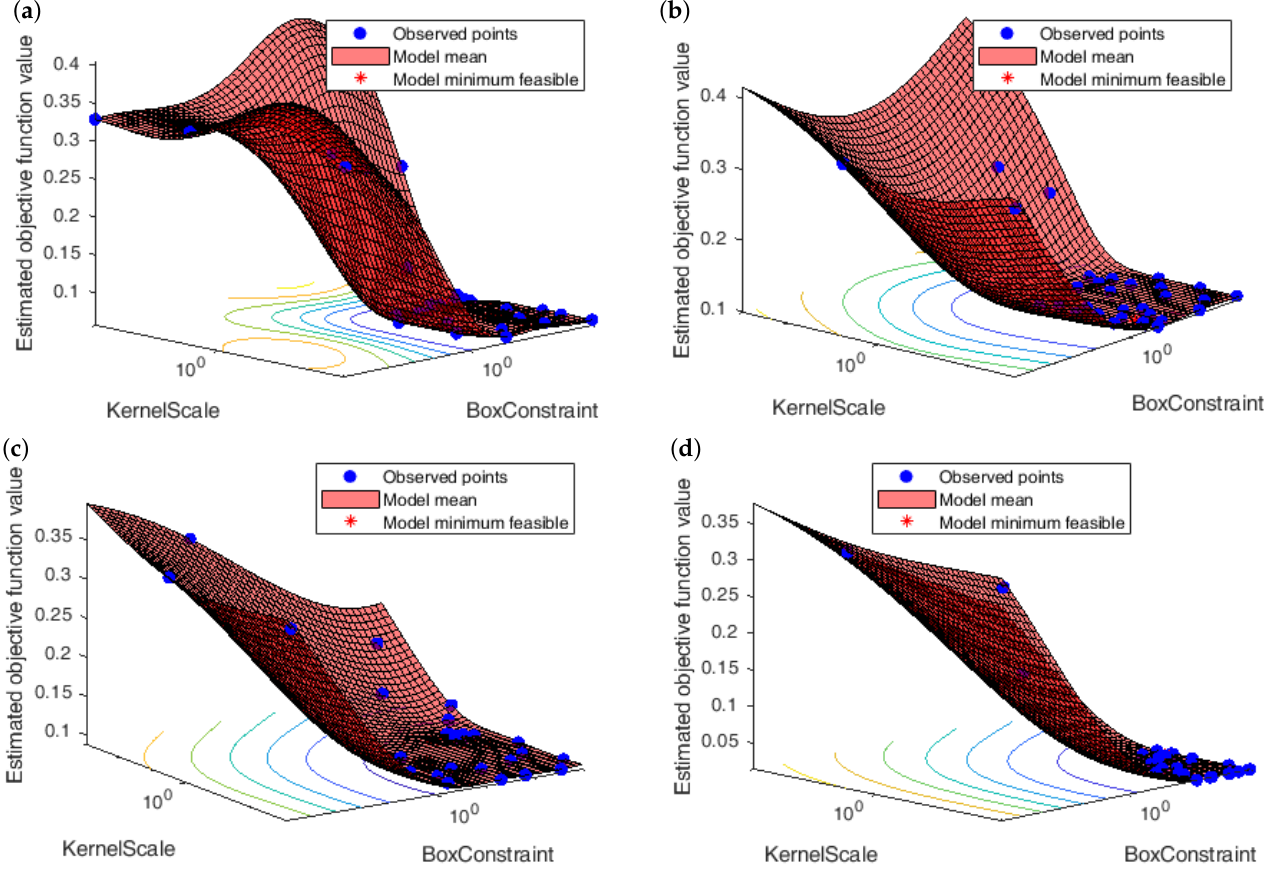
Figure 3. Estimation of box constraint ( ˆ C ) and kernel scale ( σ ) of SVM models using Bayesian optimisation by choosing a different feature set which is comprised of ( a ) demographic factors; ( b ) economic factors; ( c ) psychographic factors; and ( d ) all factors combined